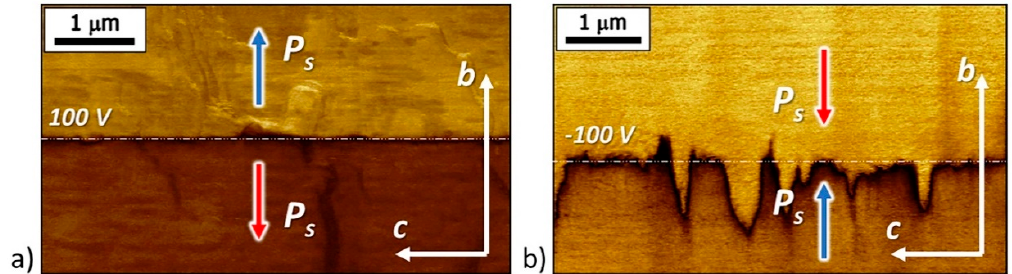
Figure 12. PFM images of the charged domain walls: ( a ) Tail-to-tail and ( b ) head-to-head. Domain walls were written by applying of ( a ) positive (100 V) and ( b ) negative ( − 100 V) voltage pulses with duration of 60 s at points located along the straight dotted line with period 1.5 μ m.